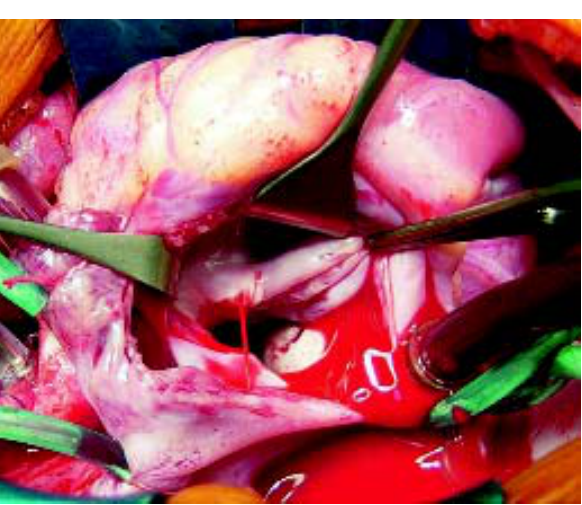
Fig. 1 – Átrio esquerdo visibilizado através de abertura do átrio direito e septo interatrial. O apêndice atrial esquerdo foi invertido e a administração de cardioplegia possibilitou localização adequada da